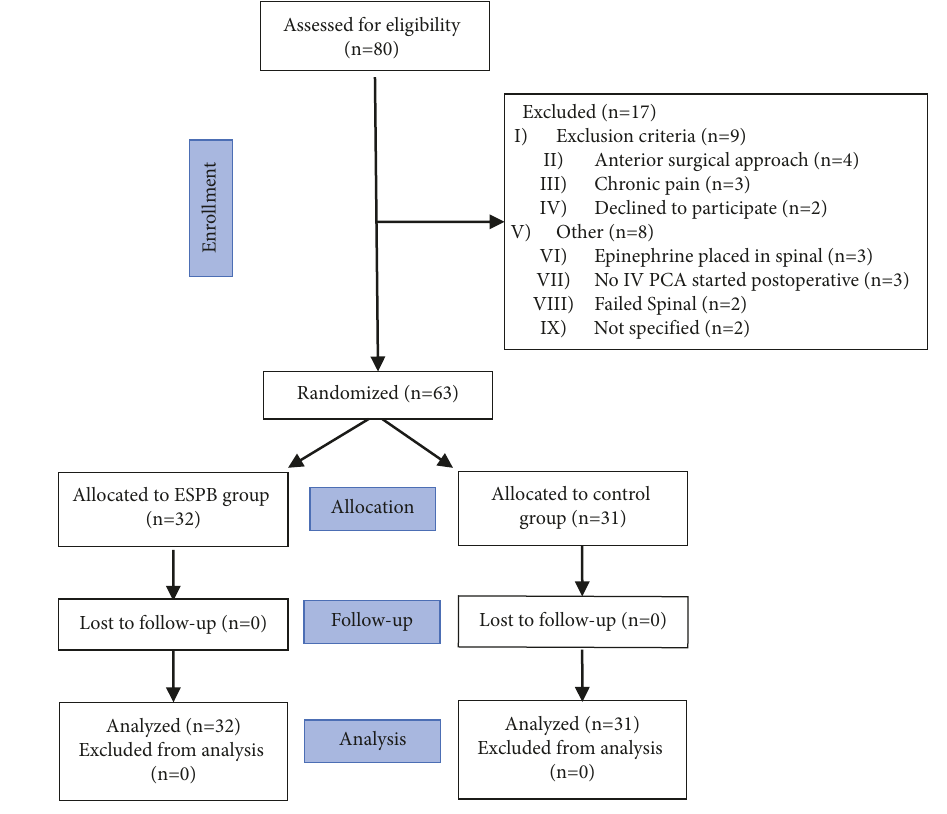
Figure 2: CONSORT diagram of the study. Table 1: Baseline characteristics of study